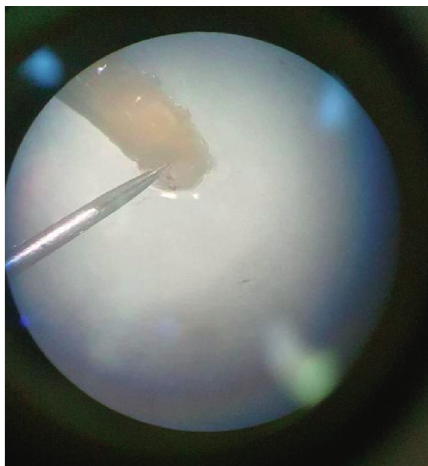
Figure 2: Posterior spiracles (before dissect).